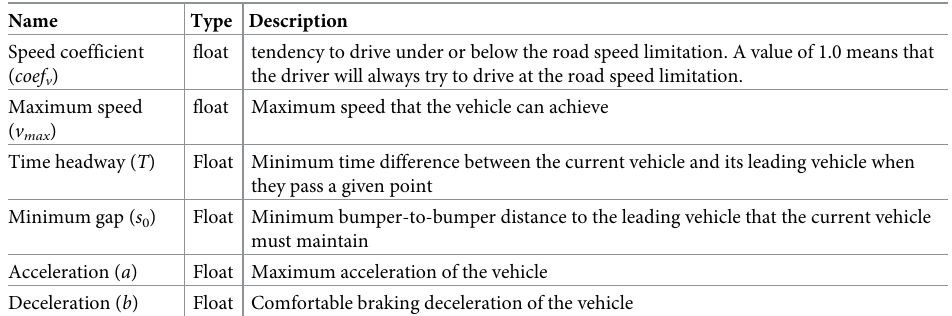
Table 5. Attributes related to speed